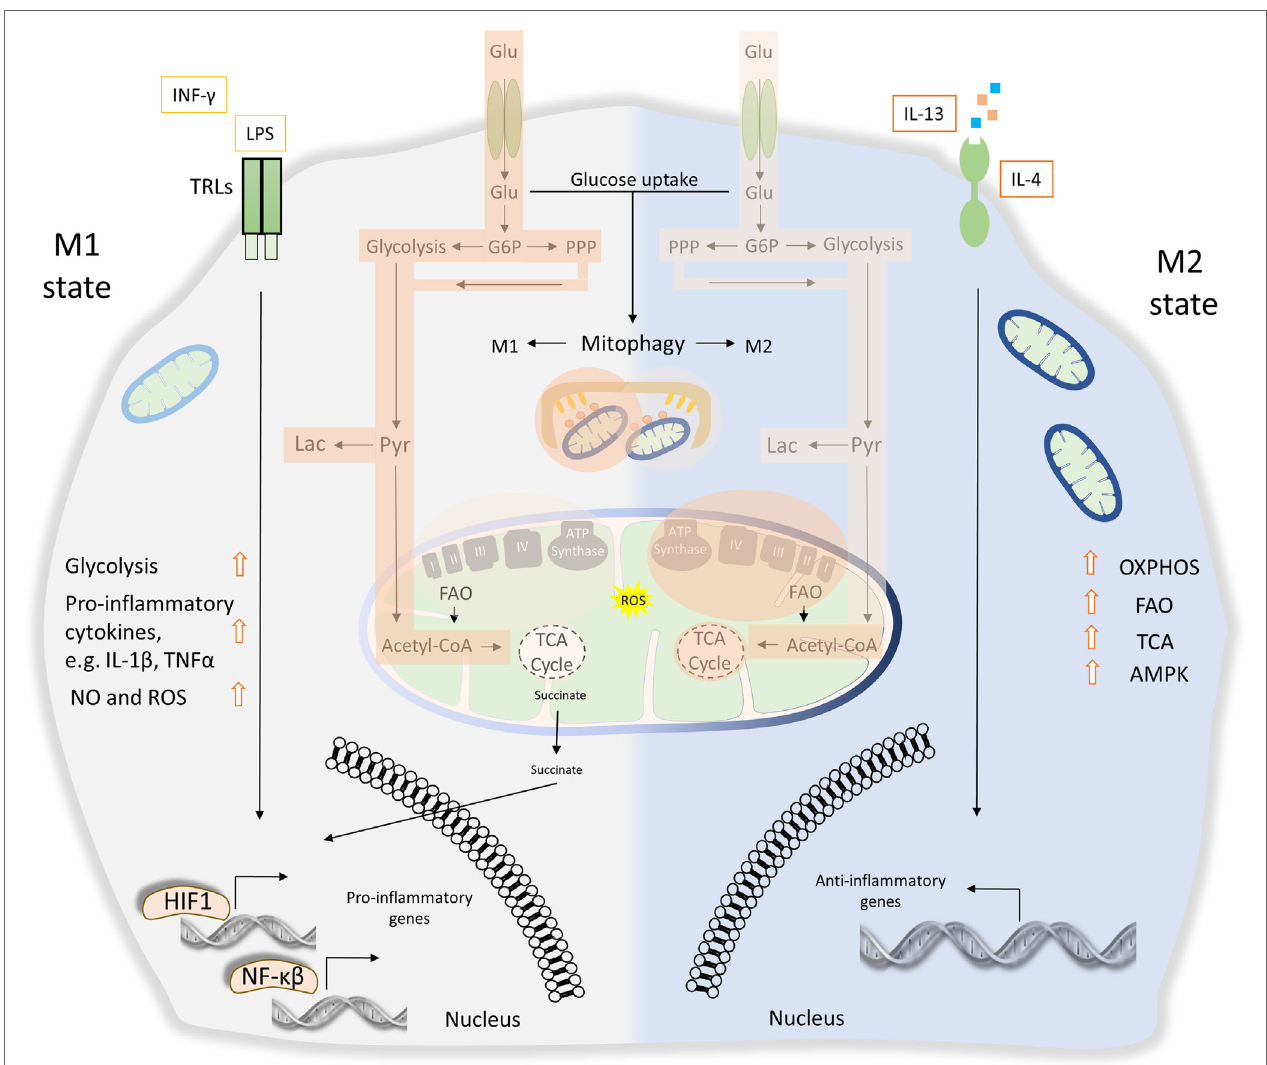
FiGURe 4 | The role of energy homeostasis and mitophagy in metabolic signature of M1 and M2 polarization. M1 macrophages are characterized by secretion of pro-inflammatory cytokines, such as interleukin (IL)-1 β and tumor necrosis factor α (TNF α ). Thus, M1 macrophages display high tumoricidal and microbicidal properties. M1 macrophages rely heavily on glycolysis accompanied with increased glucose uptake and pentose phosphate pathway (PPP). Metabolic byproducts, such as reactive oxygen species (ROS) and nitric oxide (NO), are abundantly produced. During M1 macrophage polarization, succinate is released to the cytosol and promotes stabilization of hypoxia-inducible factor 1 (HIF1), which in turn drives the transcription of several genes involved in glycolysis. Translocation of both HIF1 and nuclear factor- κ B (NF- κ B) to the nucleus mediates the expression of numerous pro-inflammatory genes. On the other hand, anti-inflammatory function of M2 macrophages relies more on mitochondrial oxidative phosphorylation (OXPHOS), tricarboxylic cycle (TCA) fluxes, and fatty acid oxidation (FAO). AMP-activated protein kinase (AMPK) is activated and triggers FAO, which fuels OXPHOS. Mitophagy act as a key factor of M1/M2 differentiation. During M1 polarization, mitochondria clearance through mitophagy stimulation favors metabolic reprogramming to glycolysis. Activity of glycolysis, OXPHOS, TCA, and FAO is labeled with bright orange frames (less active state) and dark orange frames (more active